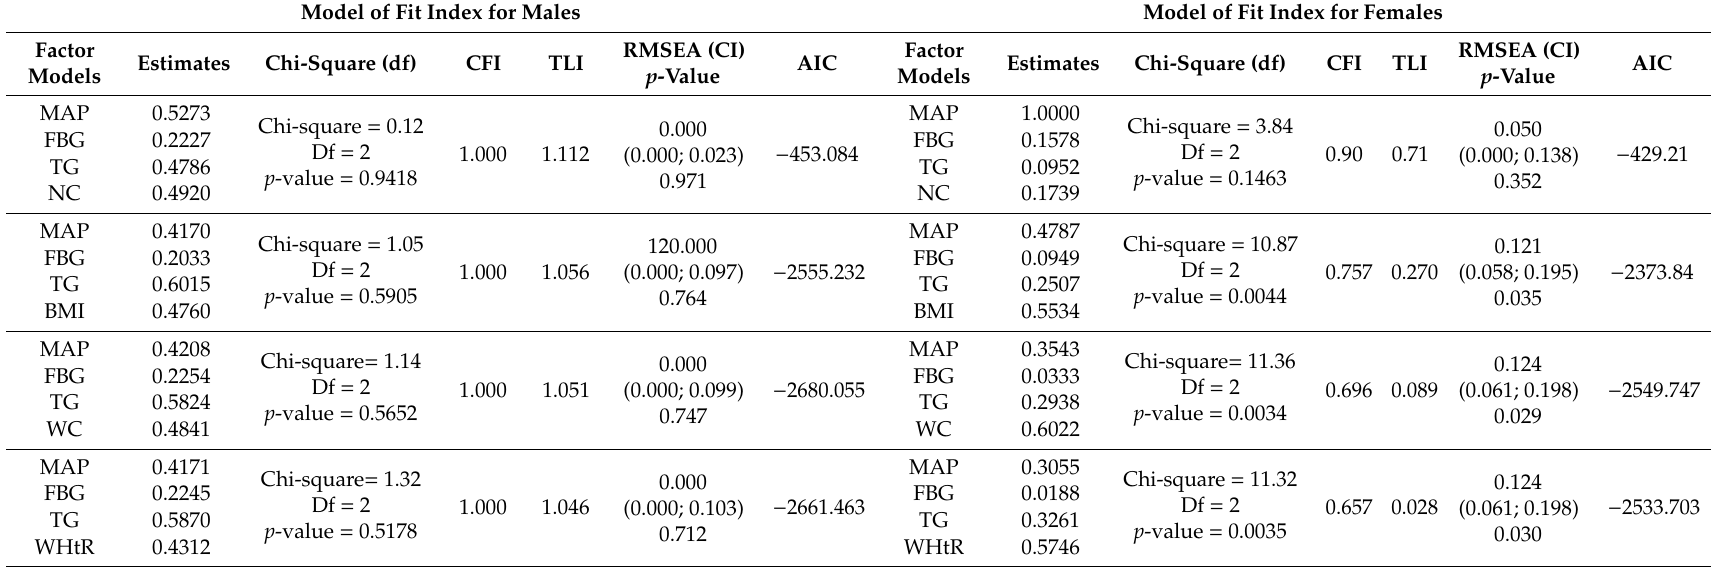
Table 3. Goodness-of-fit statistics for various factor models of MetS stratified by sex. Model of Fit Index for Males Model of Fit Index for